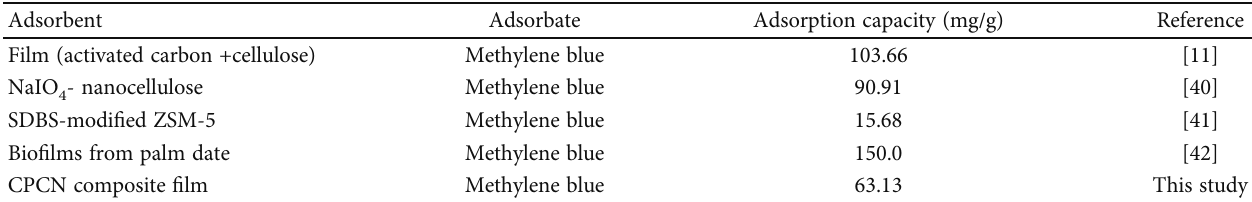
Table 3: Adsorption capacity of various adsorbents to remove MB dye.